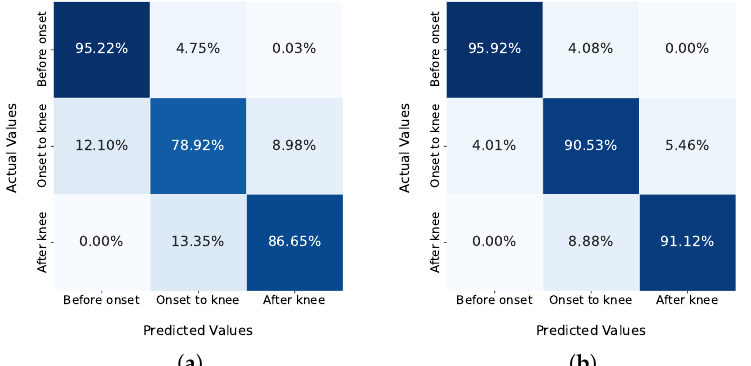
Figure 3. Model’s accuracy at classifying test cells by proximity to knee. Predictions were made from individual cycles. ( a ) Severson–Attia dataset; ( b ) Baumhöfer